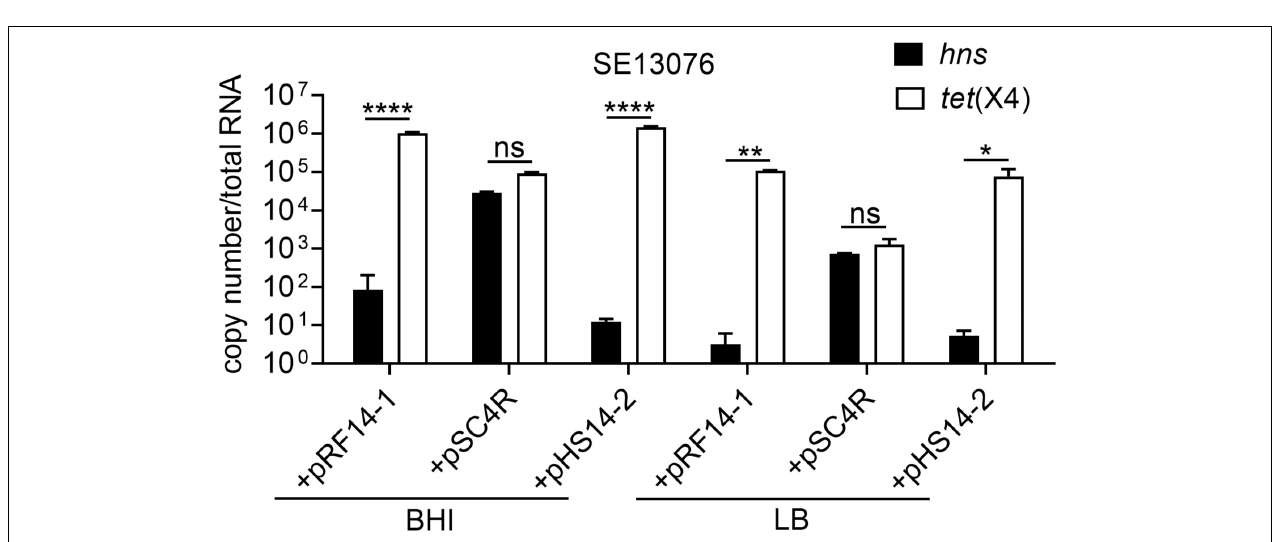
FIGURE 6 | Negative correlation between absolute expression of hns and tet( X4) gene in S. Enteritidis ATCC 13076 transformants under different nutritional cultures. The copy number of hns and tet (X4) in transformants using S. Enteritidis ATCC13076 as a recipient strain in BHI, LB, and M9 media. Data are representative of three biological replicates and shown as mean ± SD. p -values were determined by two-way ANOVA (* p < 0.05; ** p < 0.01; **** p < 0.0001; ns, not